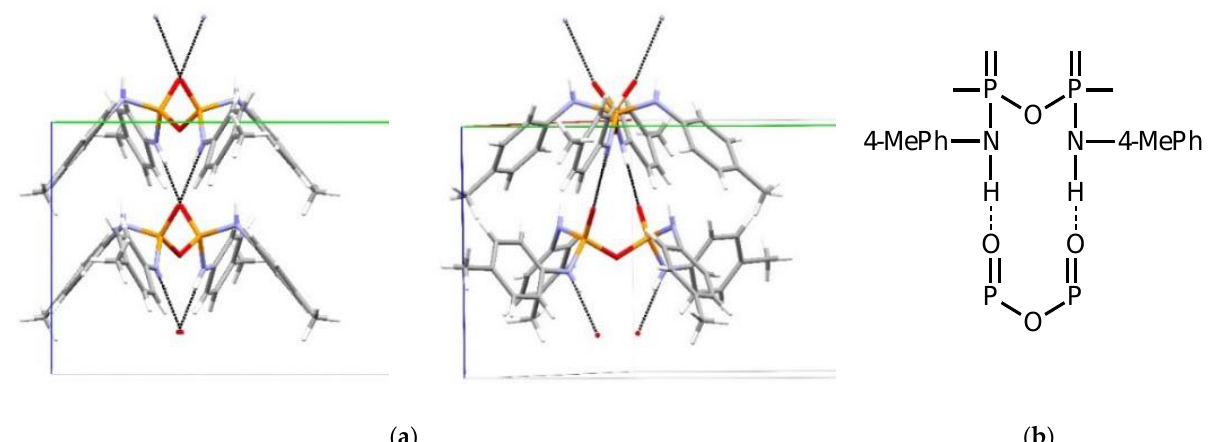
Figure 8. Hydrogen bonding motif for O((4-MePhNH) 2 PO) 2 ( a ) as viewed along the a -axis ( left ) and offset to show the staggered conformation of the pyrophosphoramide ( right ) (generated in Mercury [25]); ( b ) The ring synthon responsible for the motif given in a simplified diagram (generated using ChemSketch [24]). Chemistry 2021 , 3 , FOR PEER REVIEW